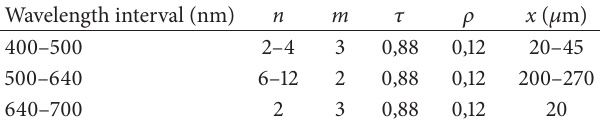
Table 2: Parameters used for modelling of internal reflectance theoretical spectrum of Spring barley (after 9 days of